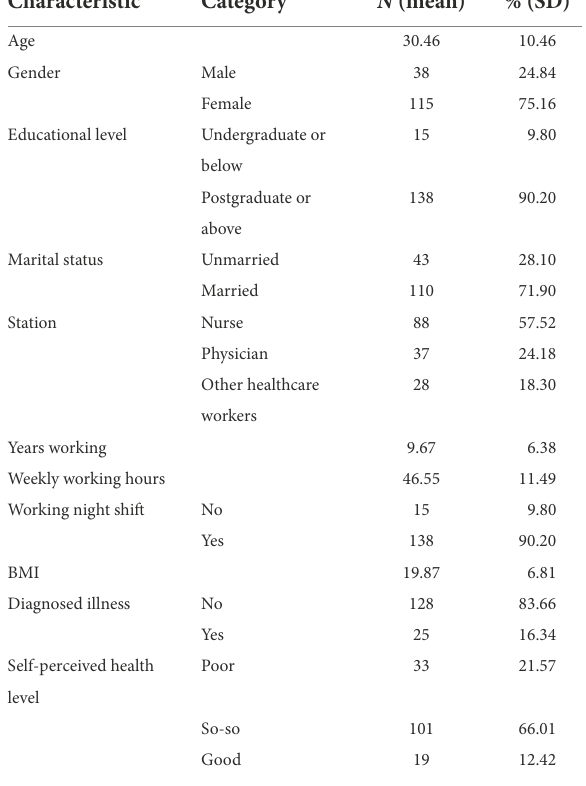
TABLE 1 Participant characteristics.